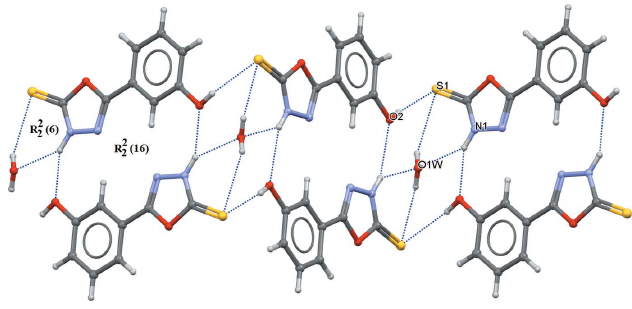
Figure 2 Formation of N—H (cid:2)(cid:2)(cid:2) O and O—H (cid:2)(cid:2)(cid:2) S hydrogen bonds (dashed lines) in the crystal structure, leading to R 2